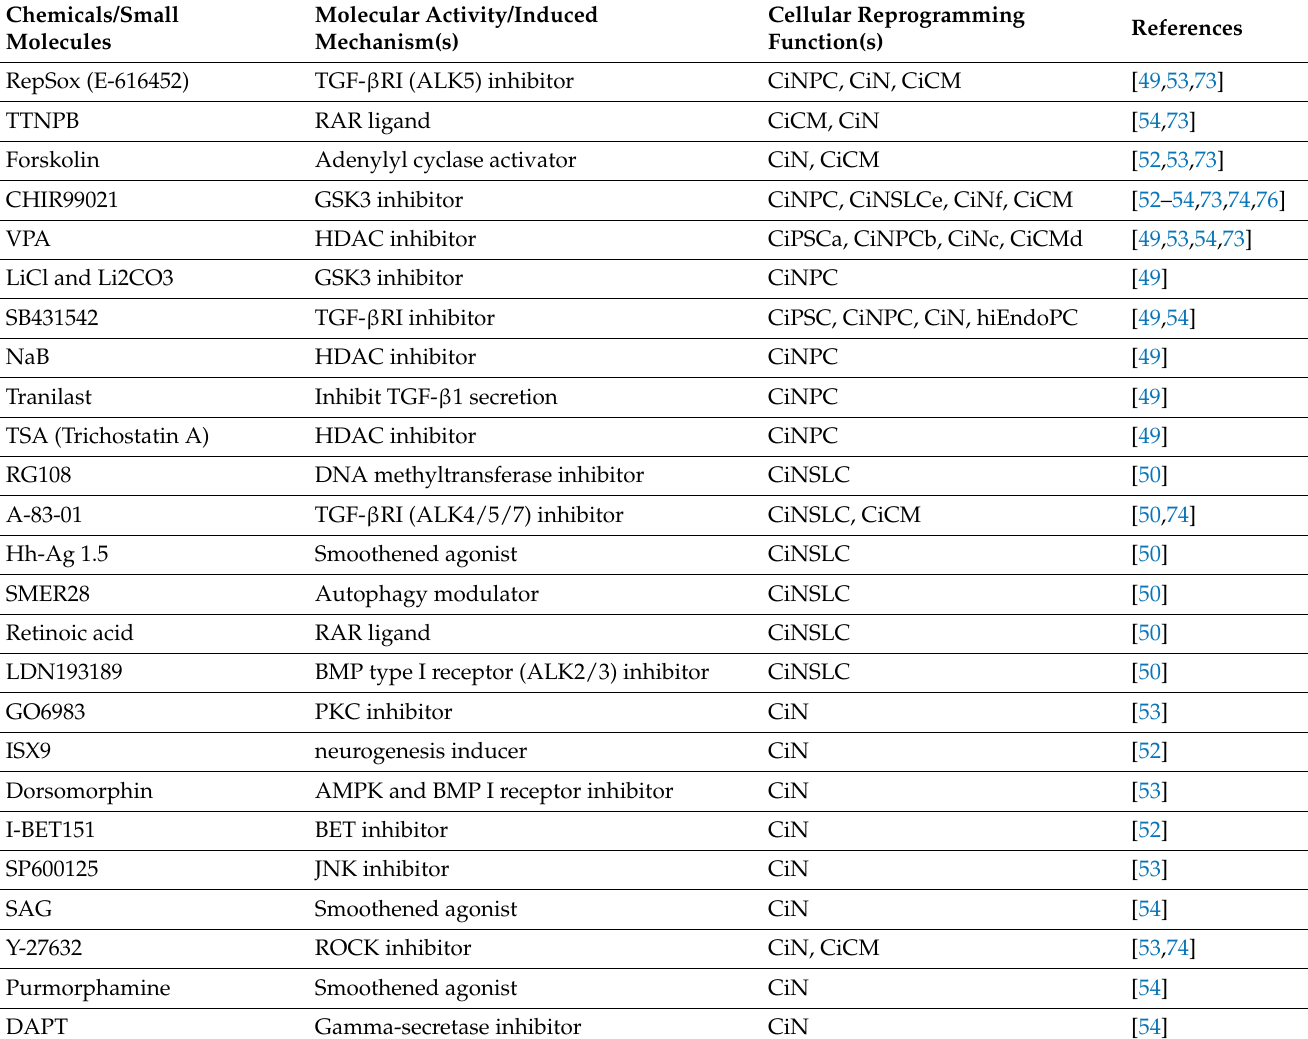
Table 3. Chemicals/small molecules-induced cellular reprogramming and their molecular activity/function(s) in neuronal and cardiac model